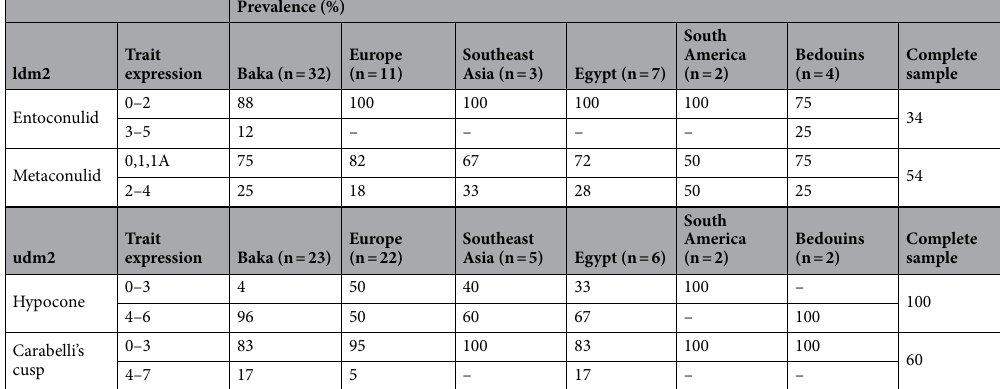
Table 5. Prevalence and degree of expression of the deciduous upper and lower second molars’ (udm2 and ldm2, respectively) discrete dental traits, observed on the outer enamel surface. n number of